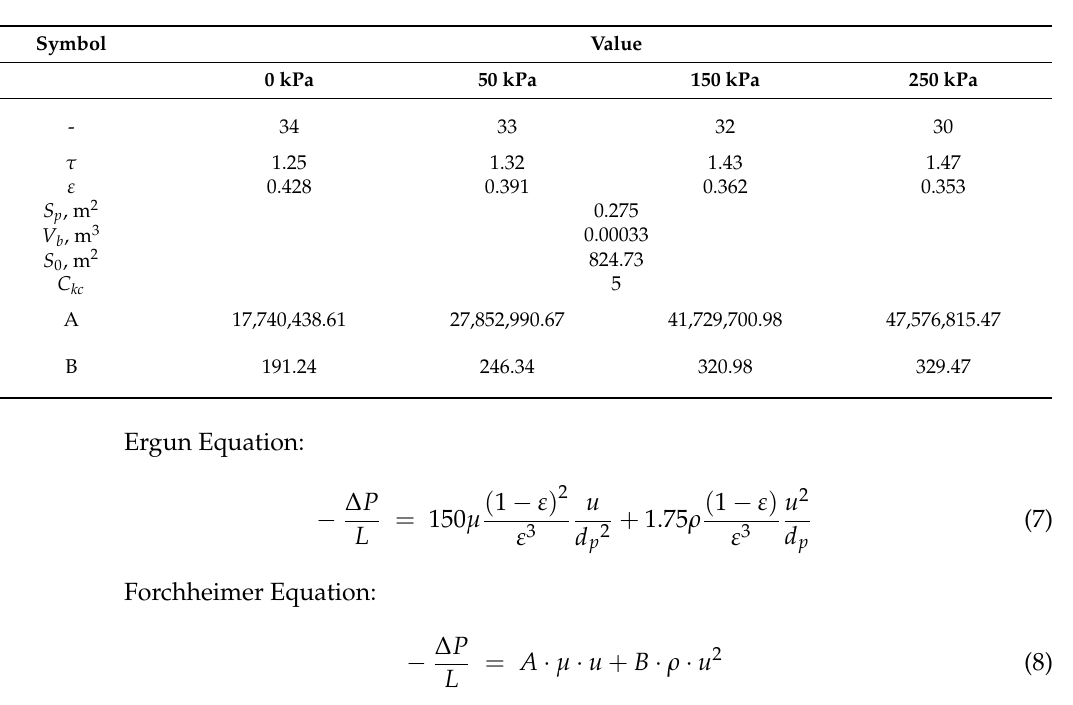
Table 2. Results of PathFinder code